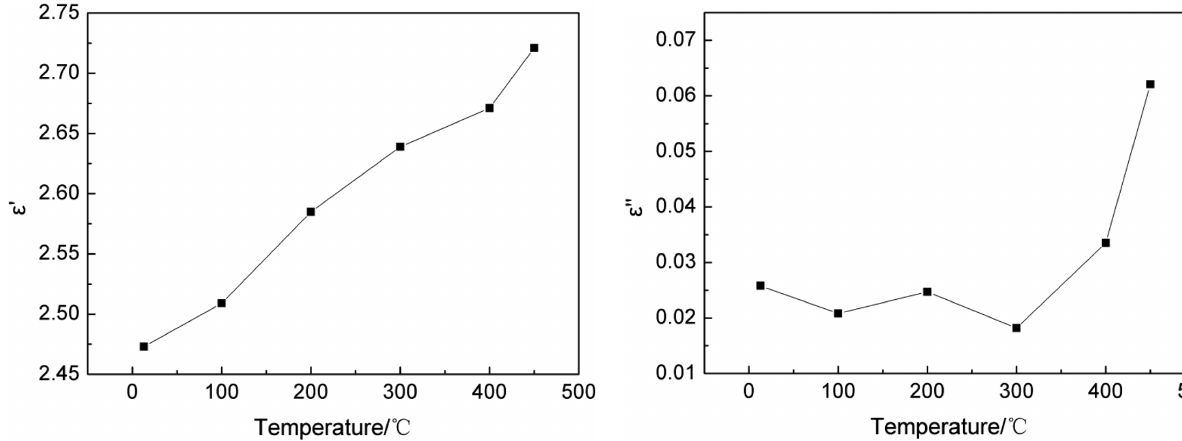
Figure 6: The variation of loss factor of CuCl residue with